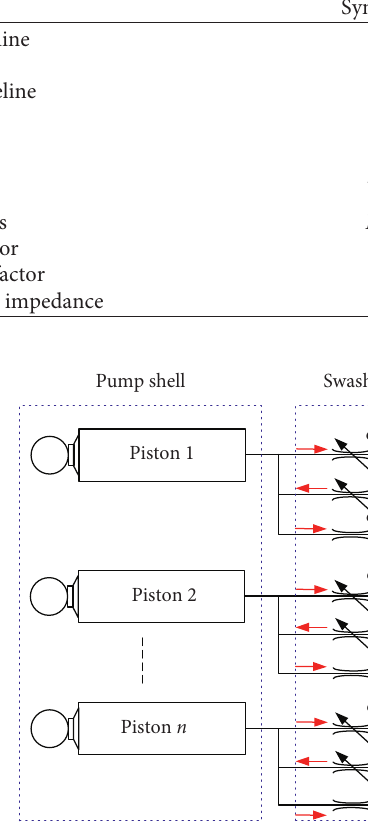
Figure 4: The mechanism of pressure fluctuation in the pipeline